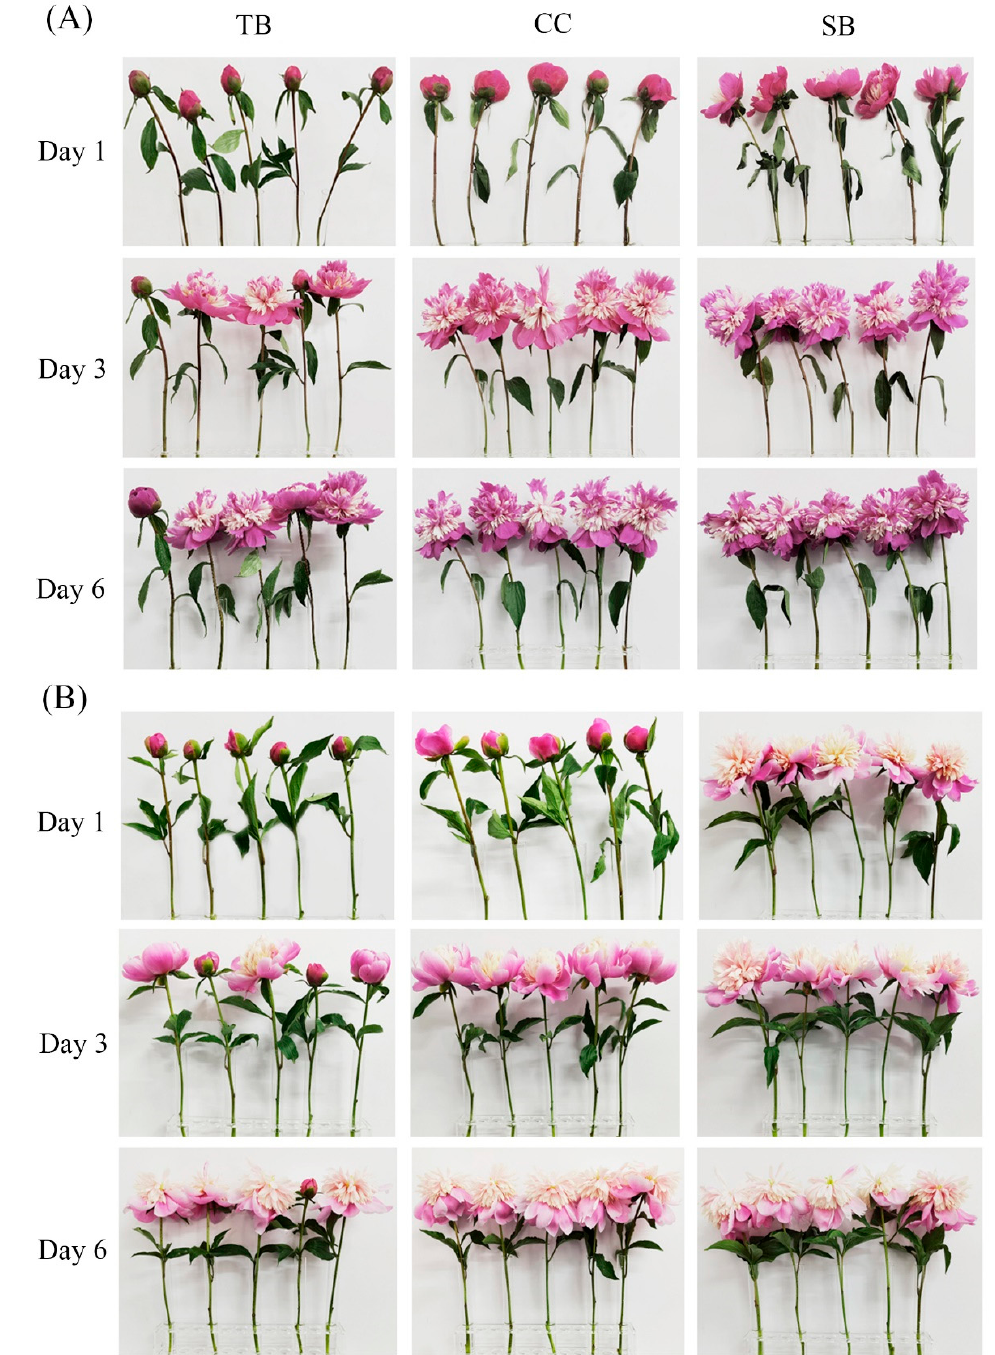
Figure 3. Flower morphological changing and physiological characteristics of in different harvest stages of “unfold-petal type” cut P. lactiflora . ( A ) The appearance of flowering changes of ‘Qihua Lushuang’ in three harvesting stages on the first, third and sixth vase day. ( B ) The appearance of flowering morphology changes of ‘Lian Tai’ in three harvesting stages on the first, third, and sixth vase day.